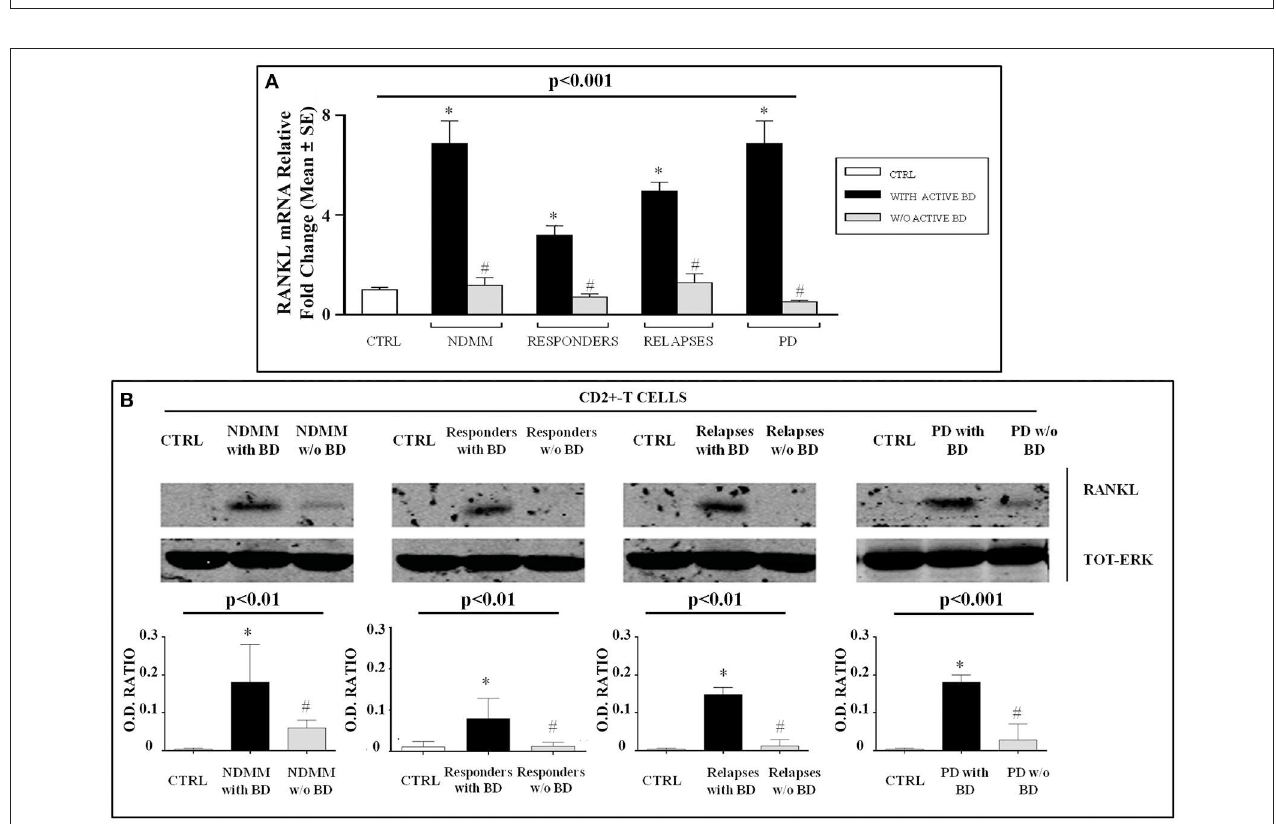
FIGURE 1 | The histograms represent the mean values ± S.E. of all enrolled patients and CTRLs (B) . Western blotting analysis showing that purified monocytes from all the patients with active BD expressed high LIGHT levels while they were significantly lower in the patients without active BD and in CTRL. The optical density (O.D.) of the bands obtained by western blotting was quantified by densitometry (histograms) and normalized to Total-ERK (C) . The histograms represent the mean values ± S.E. of all the experiments and the blots correspond to one representative experiment. P < 0.001 for comparison of all groups (one-way ANOVA on ranks), and